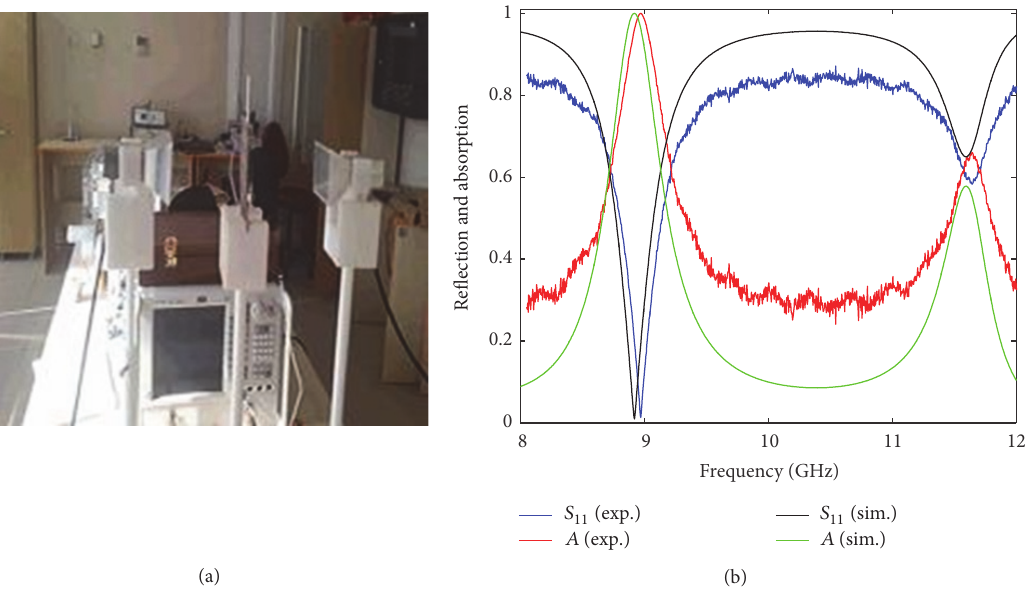
Figure 8: (a) Absorption experiment setting. (b) Simulated and measured results of reflection and absorption ratio.